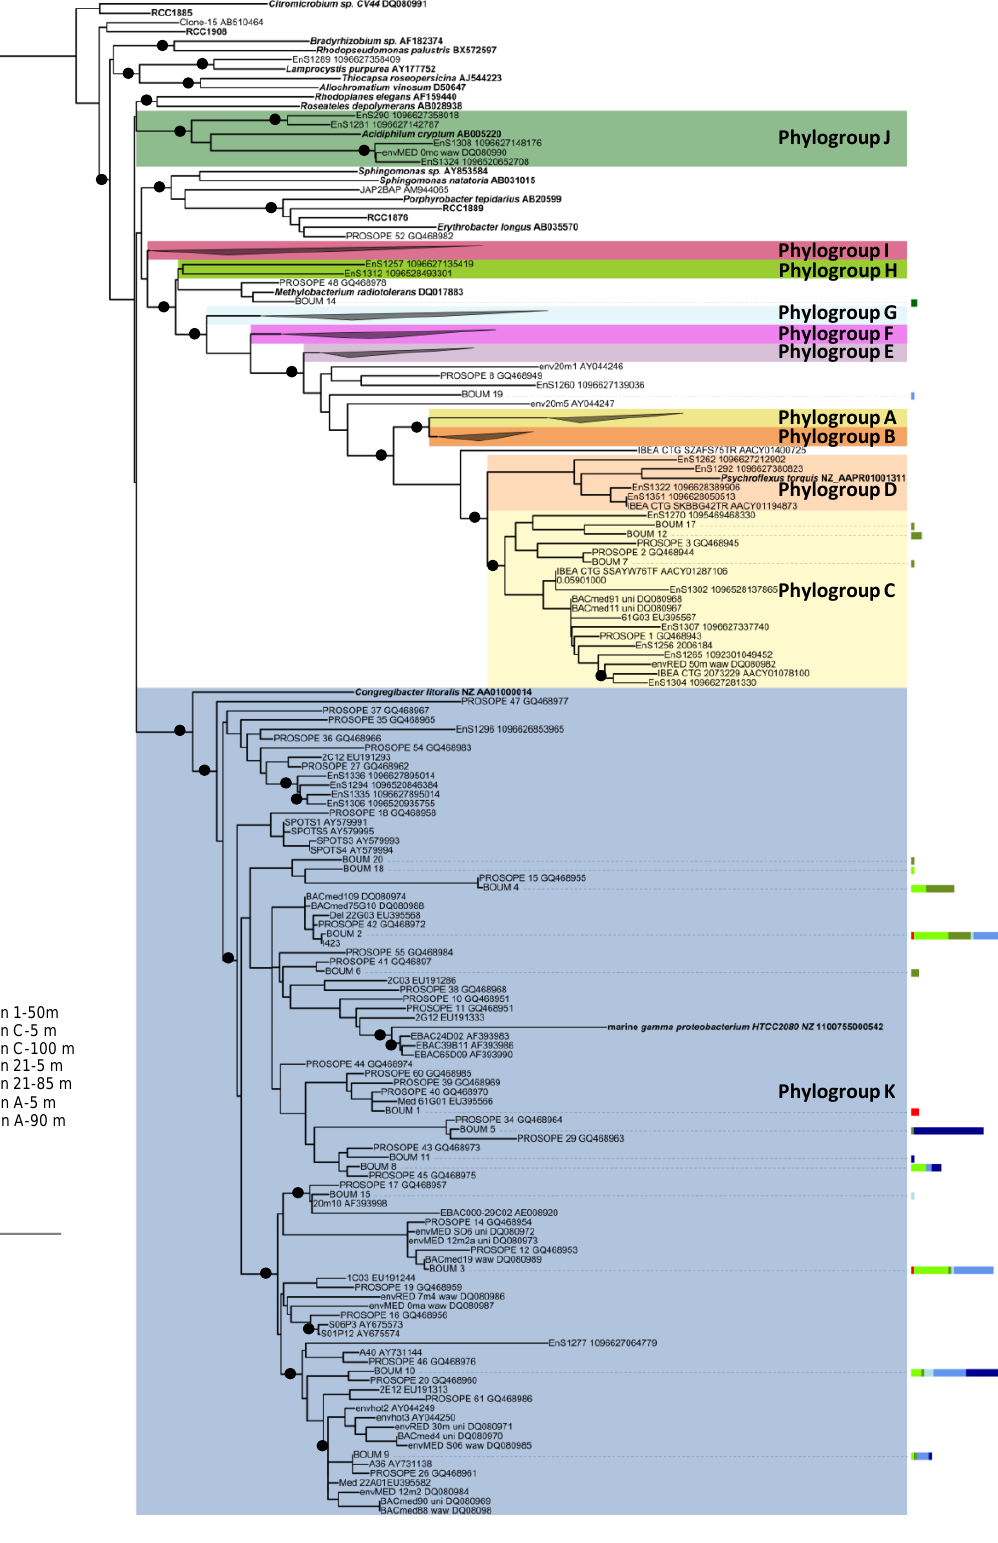
Fig. 3b. (b) Phylogenetic relationships of pufM genes affiliated to phylogroups C and K and to unidentified phylogroups. Trees are based on a neighbor-joining (NJ) tree to which Fig. 3b short sequences were added by ARB PARISMONY. Sequences used to construct NJ trees are marked in bold and black circles on nodes represent confidence values > 50%